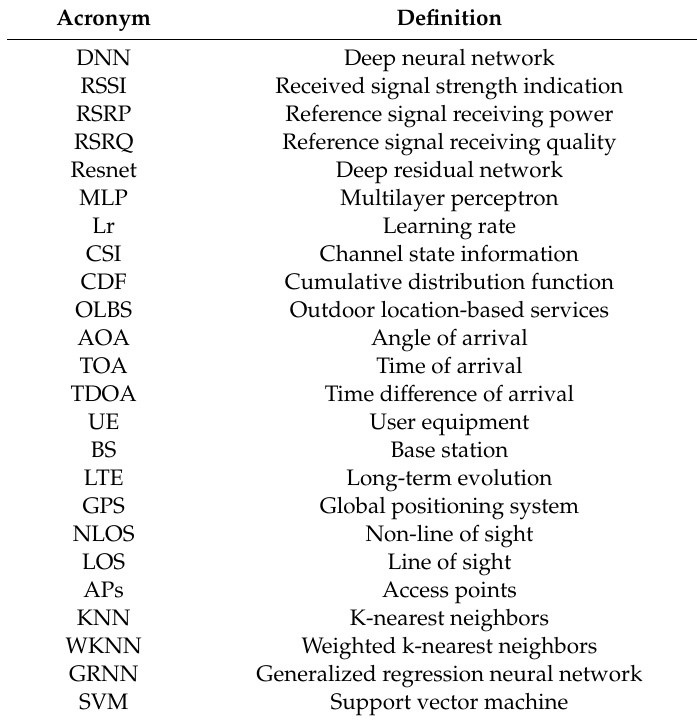
Table 1. Comprehensive list of acronyms for ease of